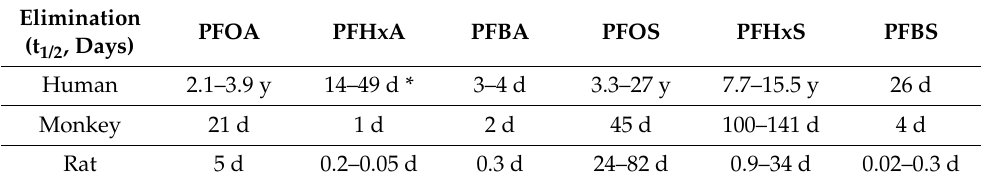
Table 4. Mean PFASs elimination half-lives (years or days). * Regards high exposure, based on Reference